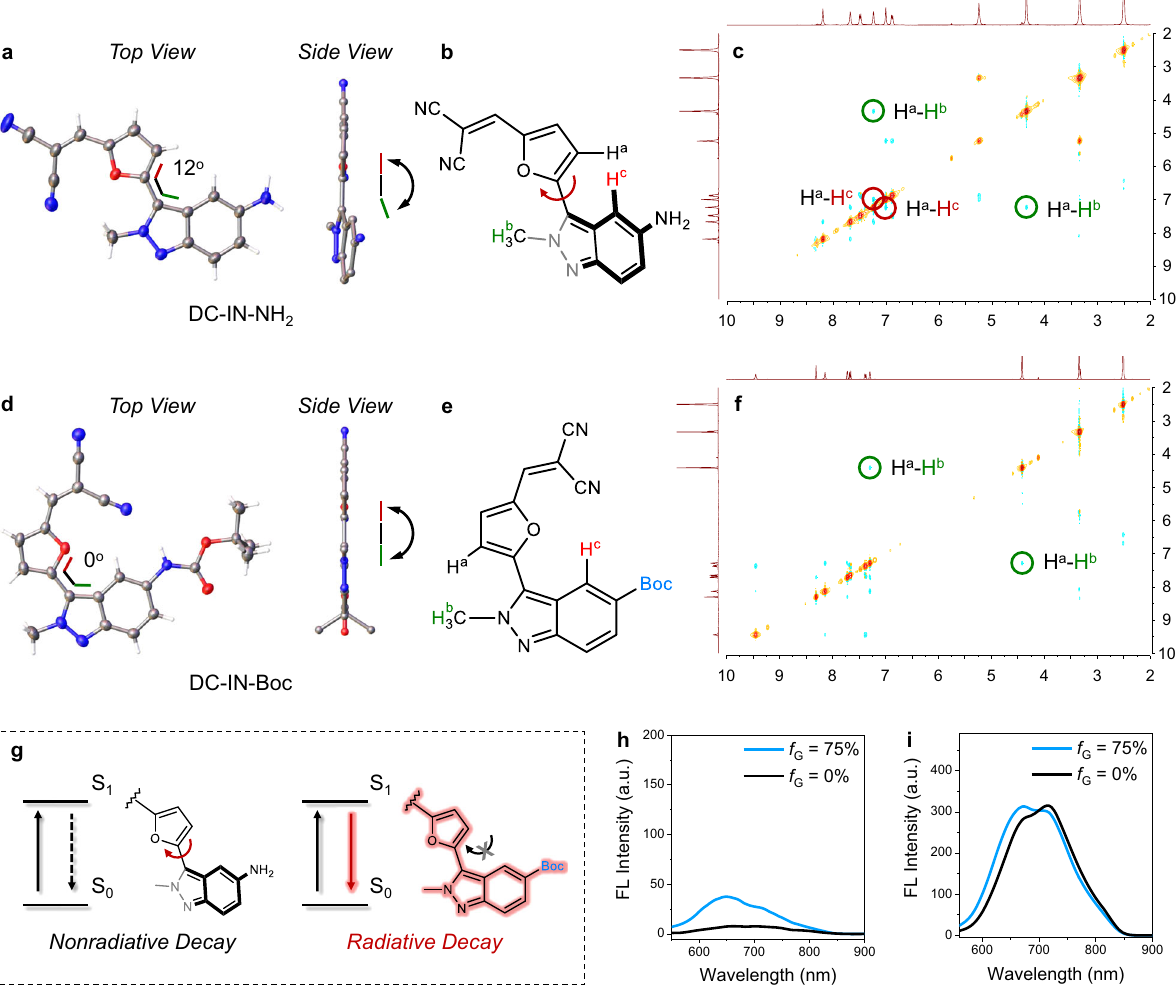
Fig. 3 Modulation of intramolecular rotation between indazole and the π -bridge. a – f Single-crystal X-ray structures and 2D-NOESY NMR spectra (in DMSO-d 6 ) of DC-IN-NH 2 ( a – c ) and DC-IN-Boc ( d – f ). g Schematic illustration of EDG/EWT controlled intramolecular rotation for regulating the fl uorescent intensity. h , i Emission spectra of DC-IN-NH 2 ( h ) and DCM-IN-Boc ( i ) in a mixture of ethanol-glycerin with different glycerin volume fractions ( f G ), λ ex = 525